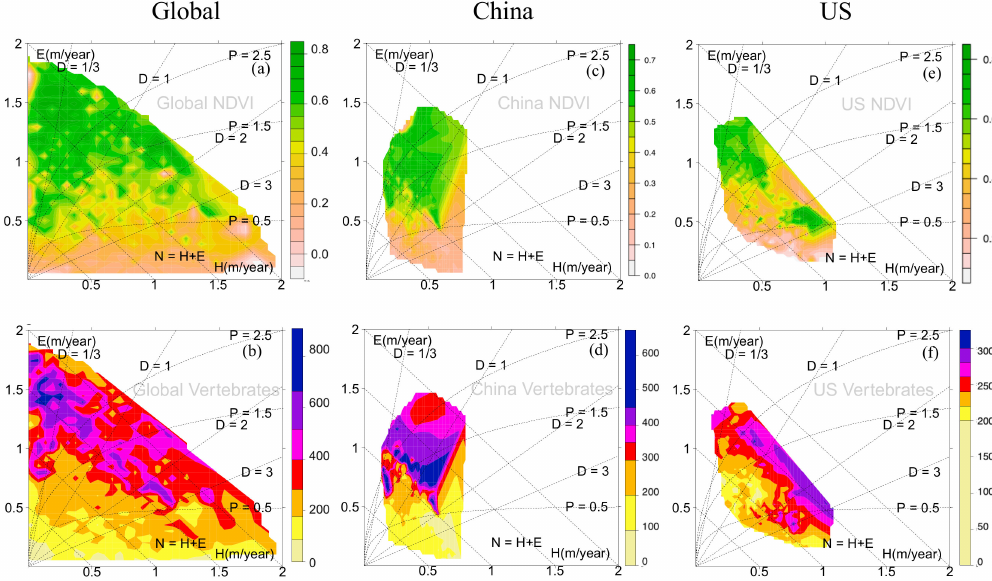
Figure 3. Vegetation greenness (upper row) and vertebrates abundance (bottom row) embedded in ( E , H )-state space across the ( a , b ) Globe, ( c , d ) China and ( e , f ) America